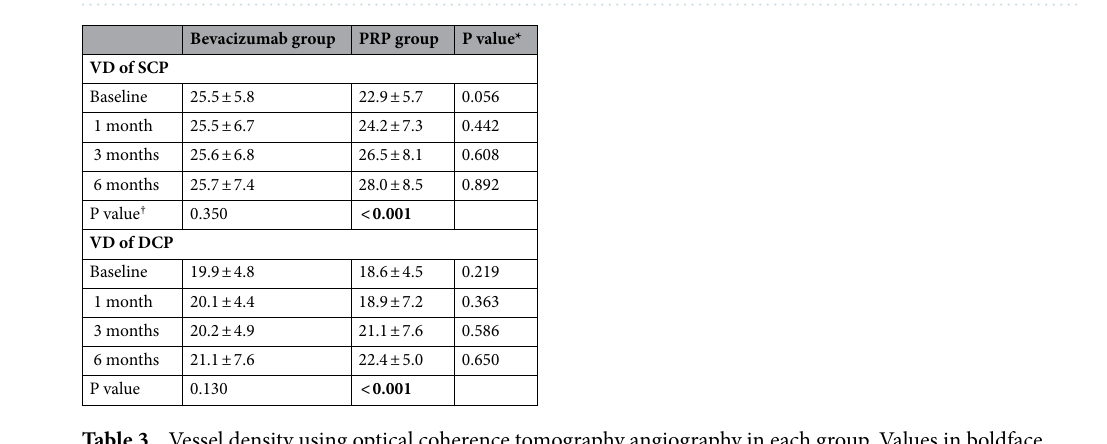
Table 3. Vessel density using optical coherence tomography angiography in each group. Values in boldface (P < 0.05) are statistically significant. All values are expressed as the mean ± SD (%). VD vessel density, SCP superficial capillary plexus, DCP deep capillary plexus. *Calculated for ANCOVA after adjusting for age. † Calculated for repeated-measures